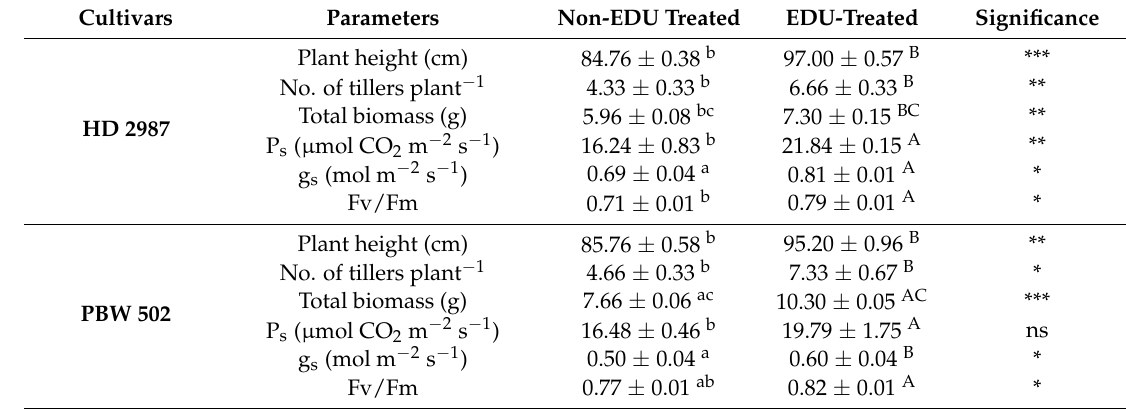
Table 2. Effect of EDU treatment on the growth, total biomass and physiology of wheat cultivars under ambient O 3 conditions. Here, P s : photosynthesis rate, g s : stomatal conductance, and Fv/Fm: photosynthetic efficiency. Values are mean ± SE; n = 9. Symbols above the bars represent significant variability between EDU- and non-EDU-treated plants. The one, two and three asterisks indicate the significance levels at * p ≤ 0.05, ** p ≤ 0.01, and *** p ≤ 0.001, and ns is non-significant. Significant variations between cultivars under EDU and non-EDU treatment are respectively represented by different capital and small letters ( p <